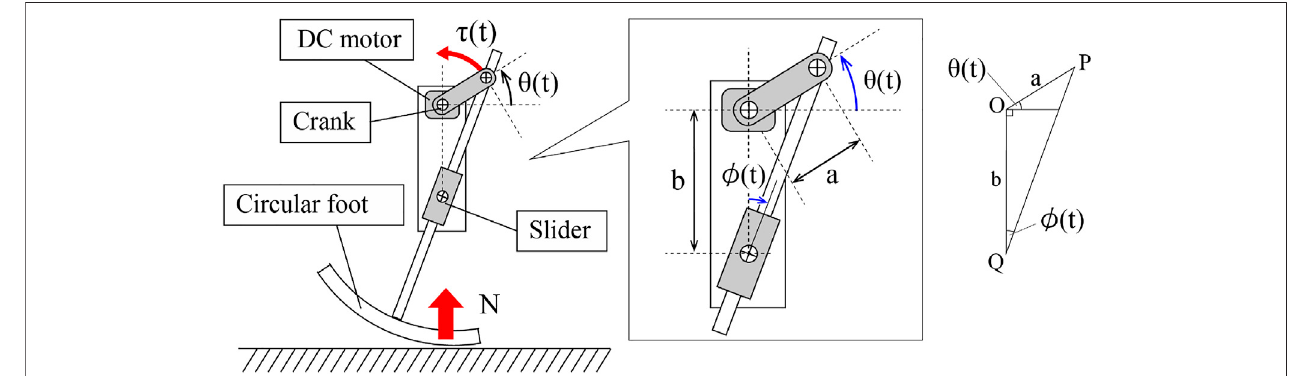
FIGURE 4 | Slider-crank mechanism of the